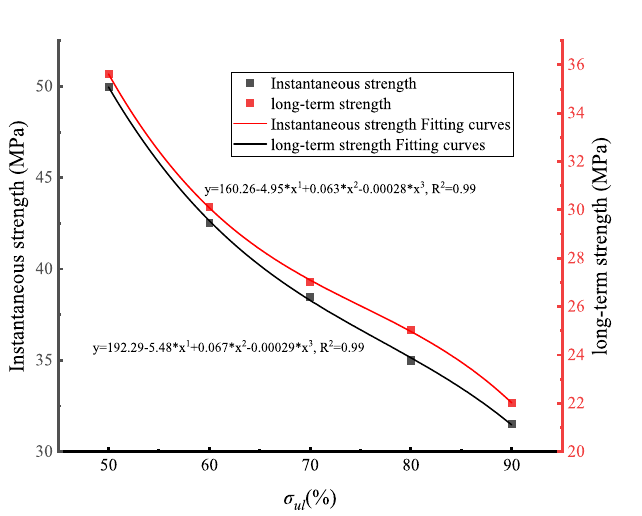
Figure 14. Long-term strength and failure strength fitting